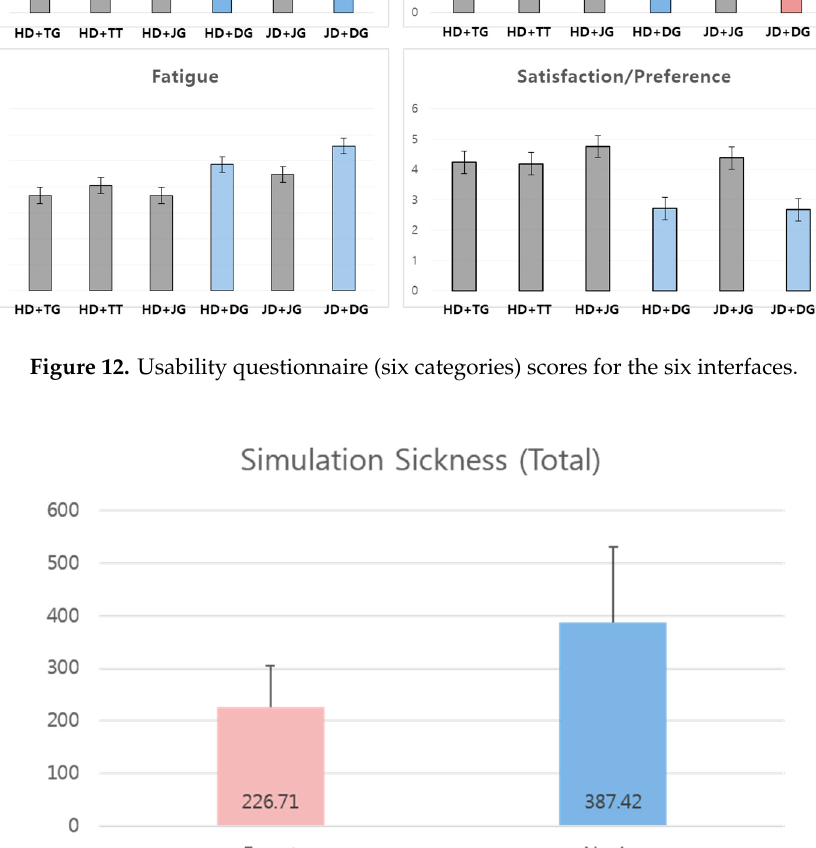
Figure 12. Usability questionnaire (six categories) scores for the six interfaces.